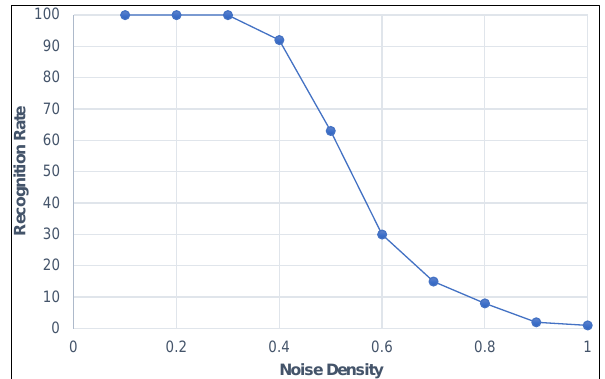
Figure 3. Performance of Face recognition under various noise conditions.